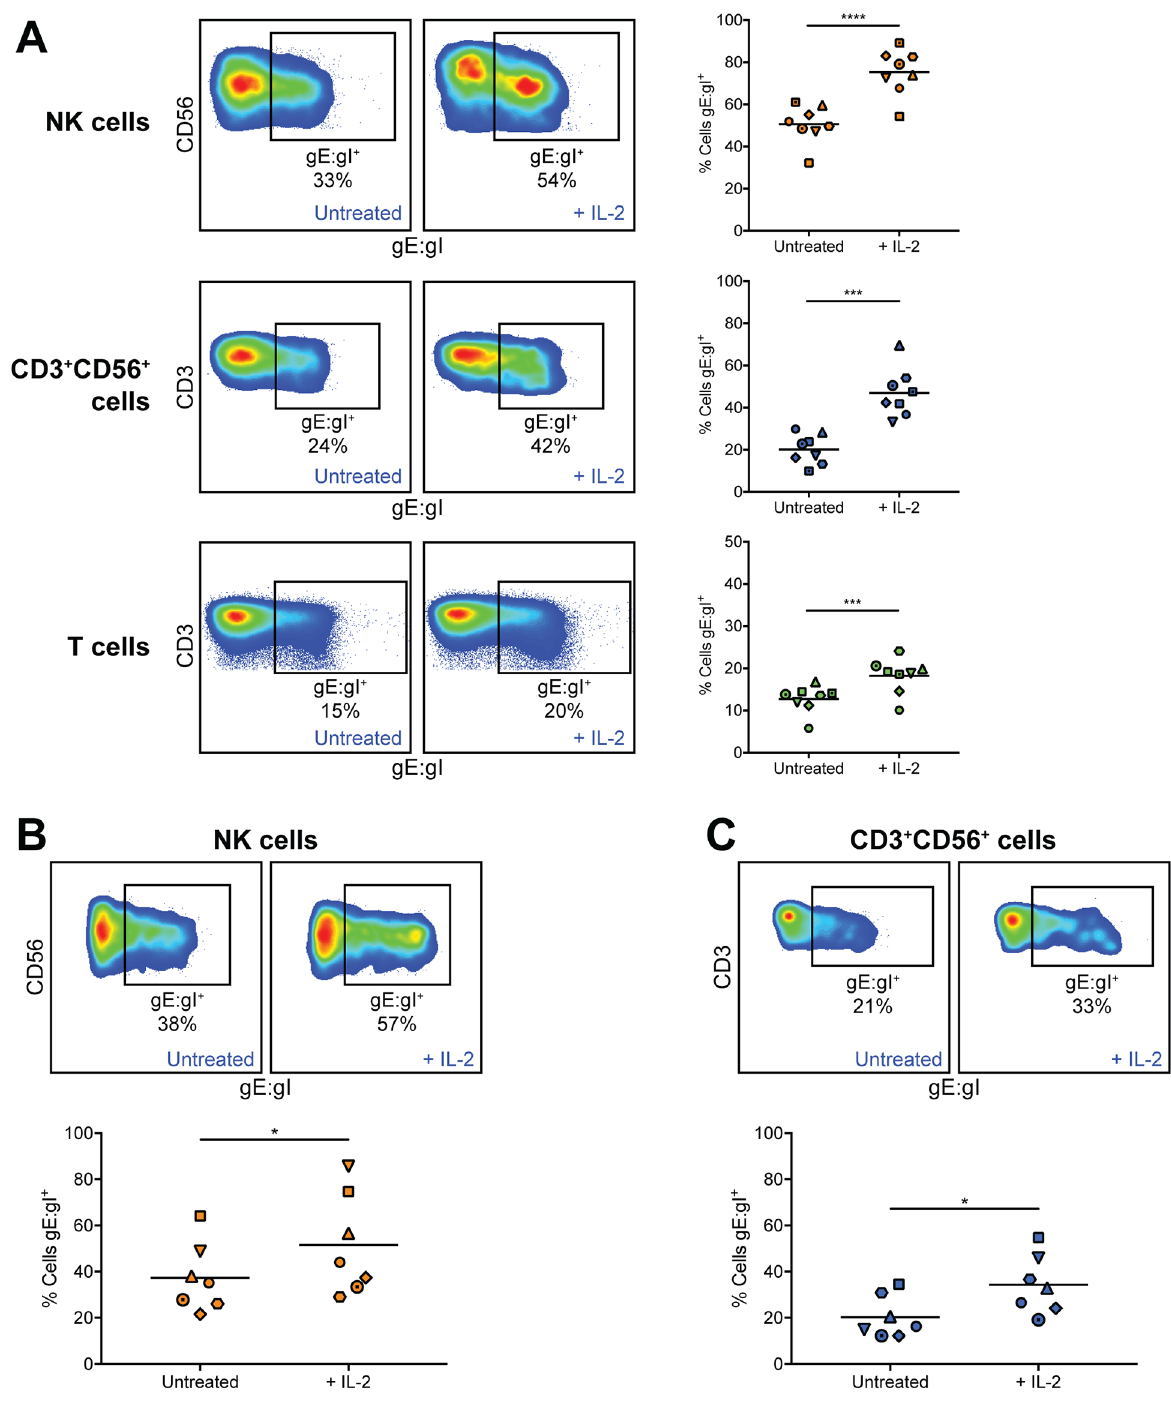
Fig 2. IL-2 stimulation of NK cells, CD3 + CD56 + lymphocytes, and T cells enhances VZV infection. (A) Healthy human donor PBMCs were infected with VZV by cell-associated infection with or without IL-2 (200 U/ml) for 2 days, then analysed by flow cytometry. Plots show surface VZV gE:gI expression from one representative donor and graphs show frequency of live gE:gI + NK cells (CD3 – CD56 + ) (top panels), CD3 + CD56 + lymphocytes (middle panels), and T cells (CD3 + CD56 – ) (bottom panels). Symbols represent individual donors consistent across lymphocyte populations, and bars indicate mean (n = 8). (cid:3)(cid:3)(cid:3) p < 0.001, (cid:3)(cid:3)(cid:3)(cid:3) p < 0.0001 (two-tailed paired t test). (B & C) Healthy human donor CD56 + -selected lymphocytes were infected with VZV by cell-associated infection with or without IL-2 (200 U/ml) for 2 days, then analysed by flow cytometry. Plots show surface gE:gI expression from one representative donor and graphs show frequency of live gE:gI + NK cells (B) or CD3 + CD56 + lymphocytes (C). Symbols represent individual donors, consistent across (B & C) (n = 7). (cid:3) p < 0.05 (two-tailed Wilcoxon matched-pairs signed rank test).